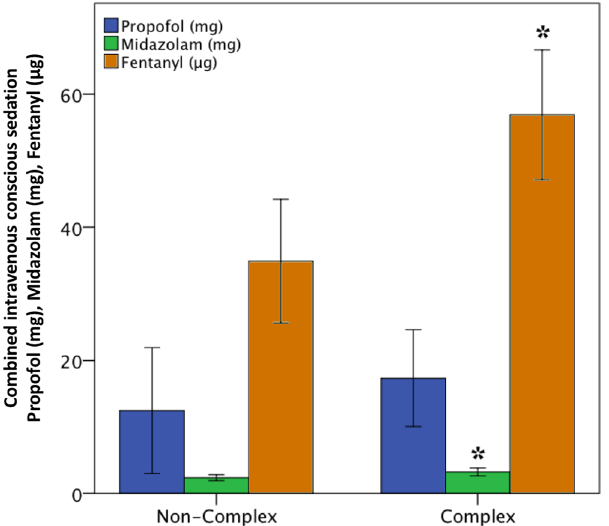
Figure 1. Mean dosages of propofol, midazolam, and fentanyl used during noncomplex and complex procedures. The error bars represent the standard error of the mean (2 SE). * p < 0.05.